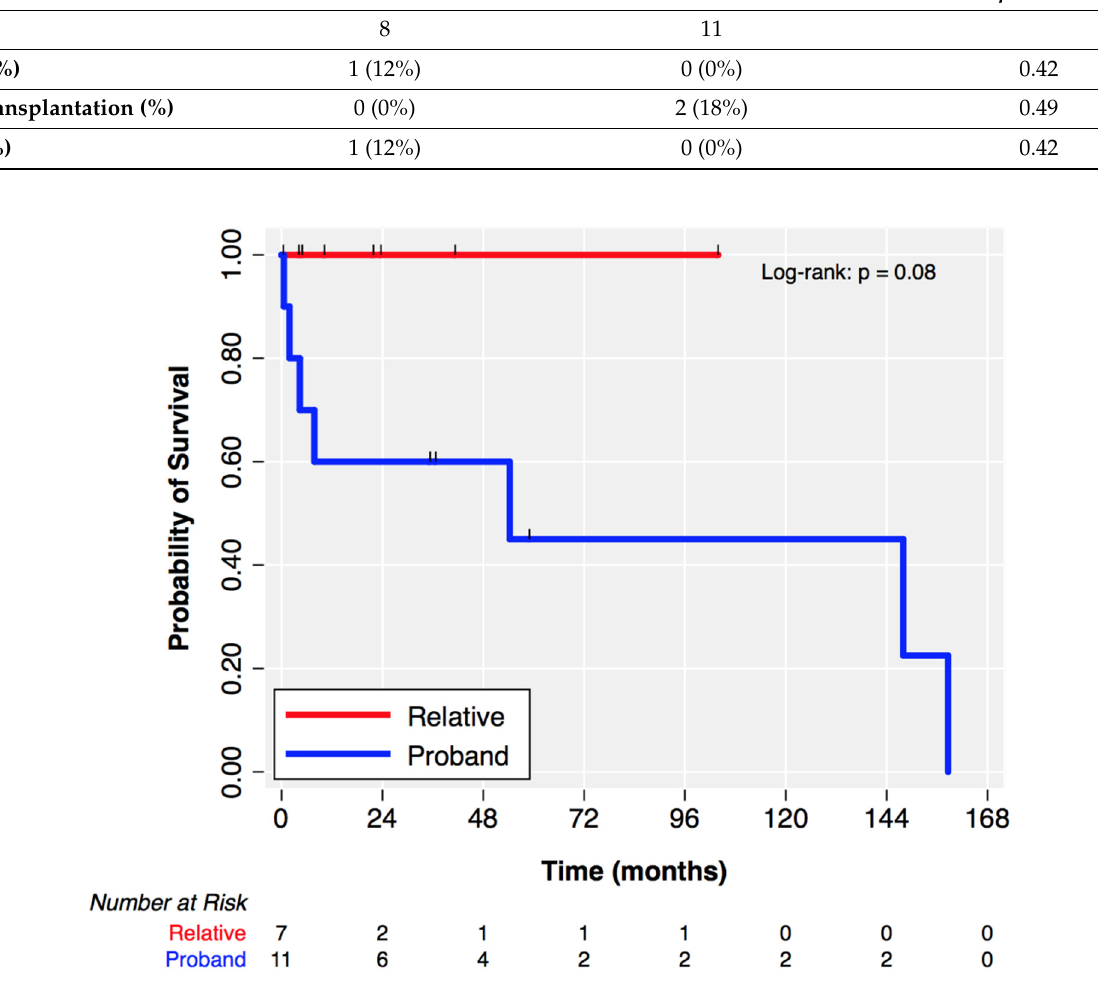
Figure 3. Kaplan–Meier estimates of event-free survival for the composite outcome of ventricular arrhythmia ablation or heart transplantation with right censoring at date of death or date of last follow-up. Tick marks indicate censored individuals. Over the observed time of follow-up, no relative underwent ventricular arrhythmia ablation or heart transplantation.